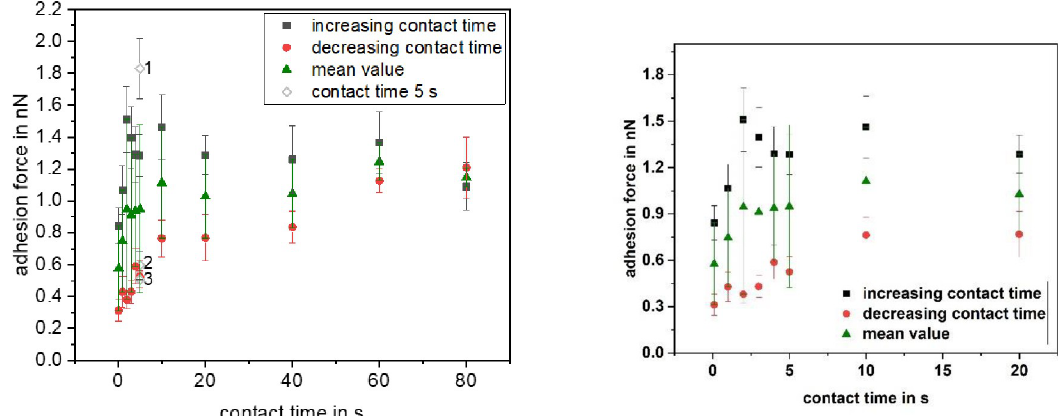
Fig 8. Influence of the contact time on the adhesion force of a single Paracoccus seriniphilus cell on glass. Each data point represents 15 force-distance curves. The data points depicted with void diamond at 5 s contact time were recorded at the beginning of the measurement (1), between the increasing and the decreasing contact times (2) and at the end of the measurement (3). On the right a zoom of the contact times up to 20 s is